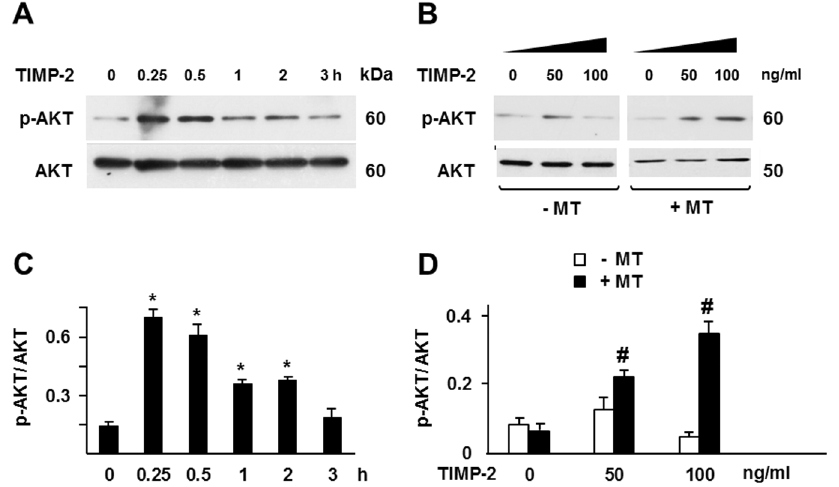
Fig 3. TIMP-2 induces AKT activation in a dose- and time-dependent manner. Western blotting analysis of AKT activation (pAKT) in MT1-MMP Tet-Off MCF-7 cells incubated with ( A ) TIMP-2 (100 ng/ml) for the indicated times or ( B ) with the indicated concentrations of TIMP-2 for 15 min. The cells shown in panel A were grown in the absence of DOX; the cells shown in panel B were grown either in the presence (-MT) or in the absence (+MT) of DOX. Total AKT is shown as a loading control. C and D . Densitometric analysis. * , p (cid:1) 0.05, vs . time 0; #, p (cid:1) 0.05, + MT1-MMP vs . the corresponding – MT1-MMP sample. These experiments were repeated twice with similar